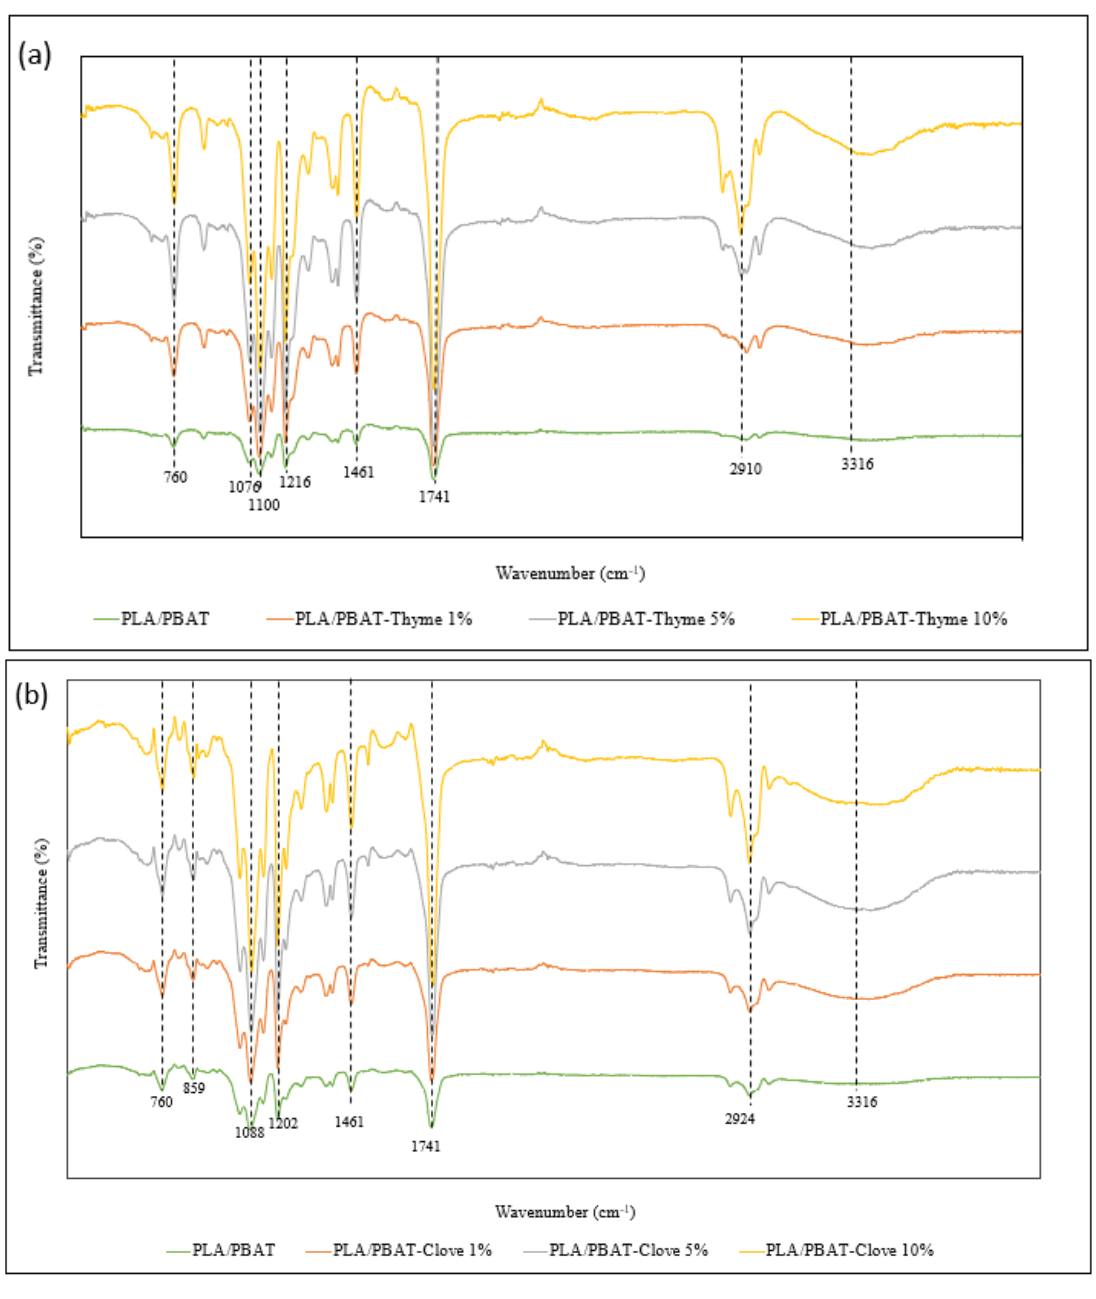
Figure 2. FTIR spectra of PLA / PBAT incorporated with ( a ) thyme oil and ( b ) clove oil composite film.